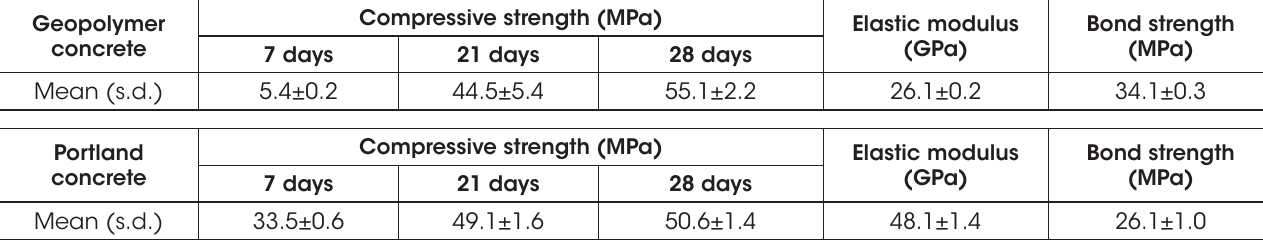
Measured mechanical properties of the two concretes Geopolymer